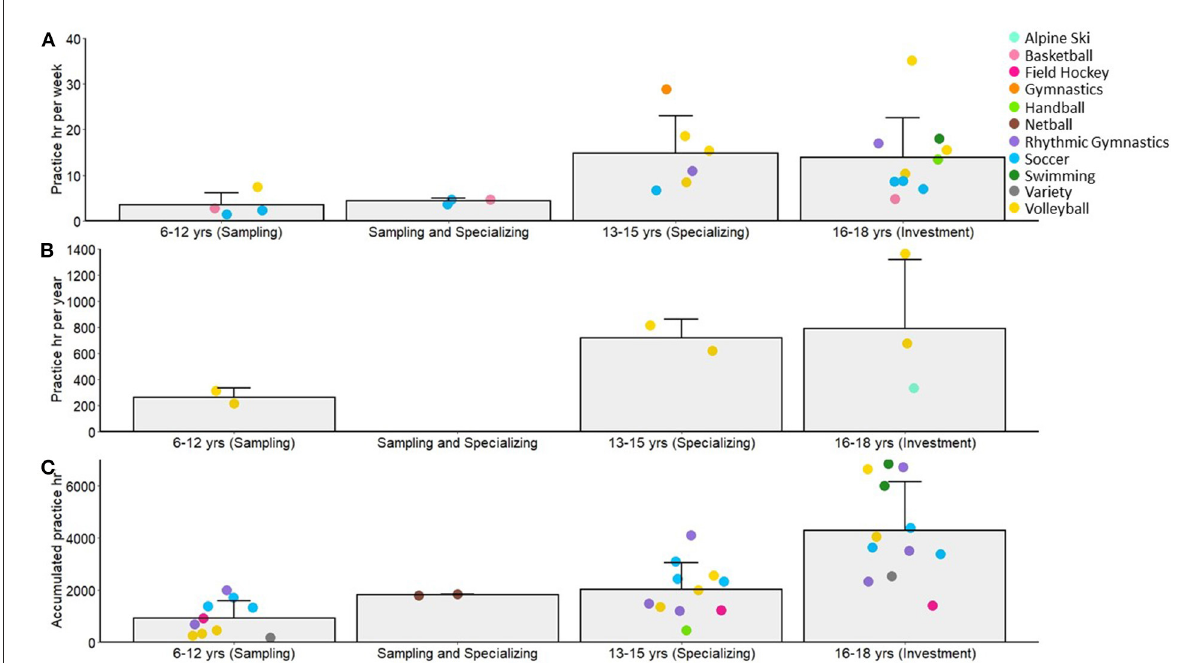
FIGURE2 Sample (bar) and individual study means (colored circles) across different age categories defined in past literature as the sampling, specializing and investment years, for practice hours per week (A) , practice hours per year (B) , and accumulated practice hours (C) . Error bars represent sample standard deviation, the intermediate category (Sampling and Specializing) contains data that were reported across ages spanning the sampling and specializing years.